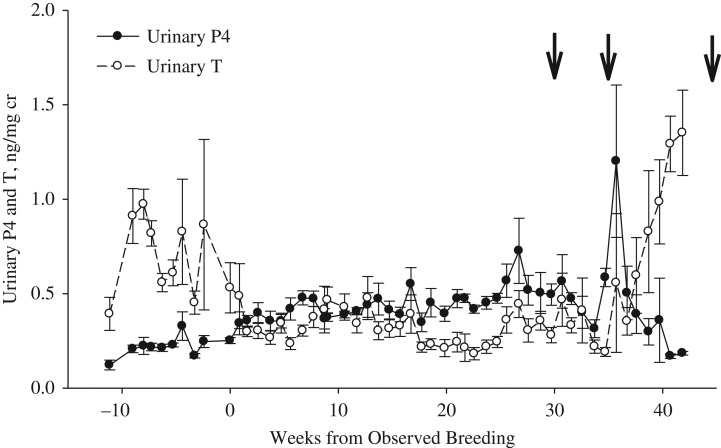
Weekly progestin (P4) and androgen (T) concentrations (mean ± SEM) in urine from a pregnant captive polar bear (SB 1132; n = 3 reproductive cycles; 2011–13) as aligned to the last day of observed breeding. The arrow represents the date when cubs were born each year.